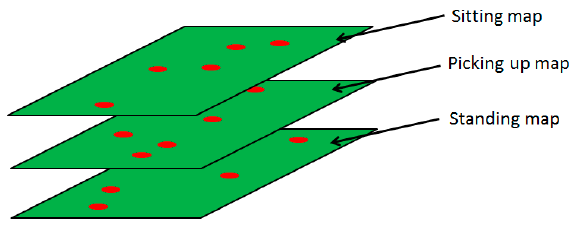
Figure 8. Illustration of behavior cognitive map.